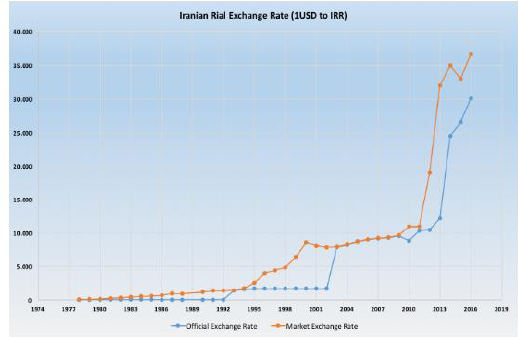
Figure 2. The U.S. Dollar Price Situation since 1978 Resource: https://ieb.today/wp-content/uploads/2016/07/ Exchange-Rate.png